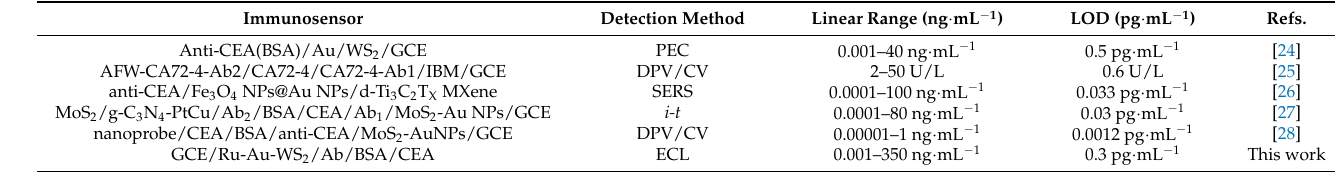
Figure 8. The selectivity of CEA 10 ng · mL − 1 and CEA 10 ng · mL − 1 mix 20 ng · mL − 1 Human Serum Albumin (HSA), prostate-specific antigen (PSA), immunoglobulin G (IgG) and alpha-fetoprotein (AFP) ( A ) and the stability of GCE/Ru-Au-WS 2 /Ab/BSA/CEA ( B ). Table 1. A comparison of different methods for the detection of